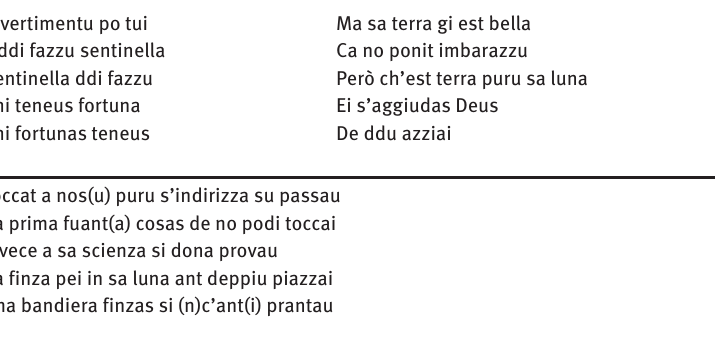
Figure 2: Transition from the AMS section (ending with De ddu azziai ) to the currentina coda (starting with Toccat ) in one APF improvised by the poet Remo Orrù, as transcribed in Rossi & Meloni 2007: 555 (translation: Fun for you / But the earth is beautiful // And I am a guard of it / Even if the moon is soil as well // If we are lucky / And God help us // If luck we have / To get to it // It is up to us to also address the past // Because previously there were things one may not touch // Instead science gives us proof // That even on the moon they have set foot // And even a flag they have planted on